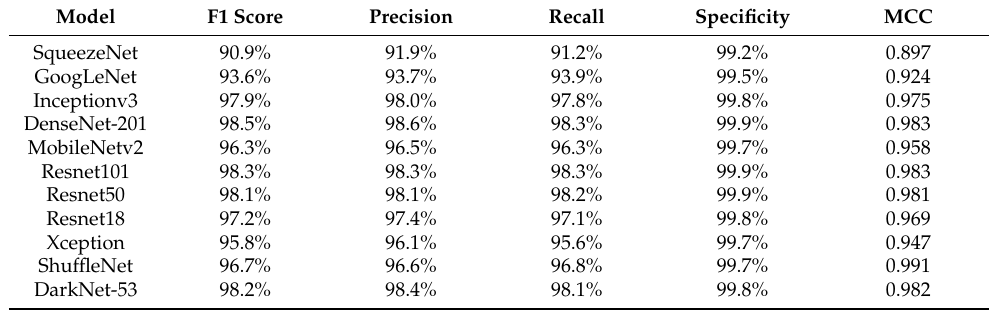
Table 1. The mean overall F1 score, Precision, Recall, Specificity, and MCC using 50% of the data for training. The results are an average of 10 runs.